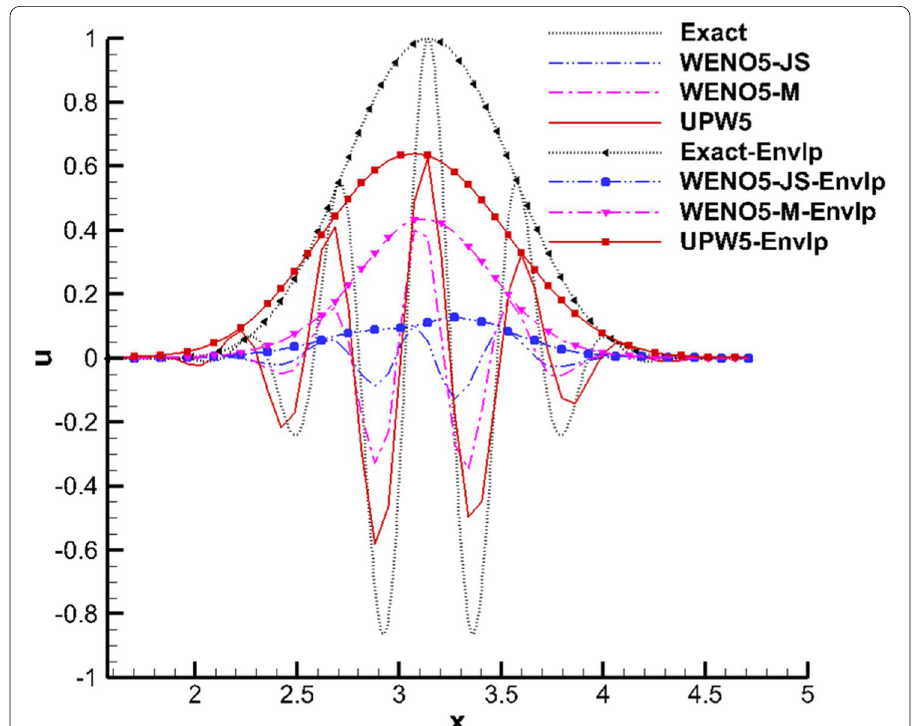
Fig. 9 Solution distributions and corresponding envelopes for T the conditions N x 48 and Δ t 10 − 3 for different spatial schemes and RK = =